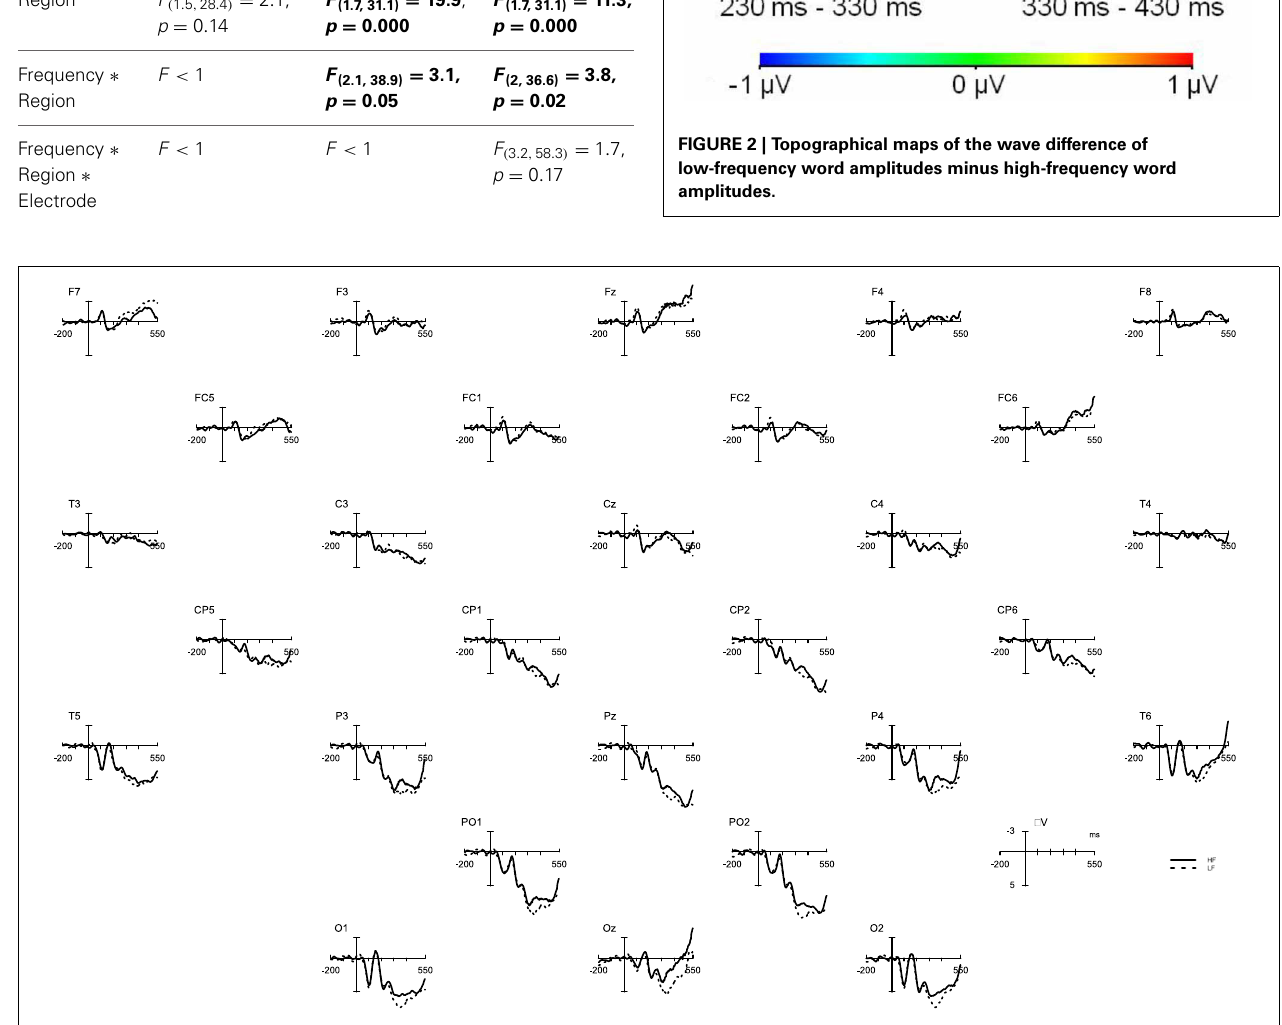
FIGURE 1 | ERP waveforms for high (solid line) and low-frequency words (dashed line) locked to the onset of the picture presentation.